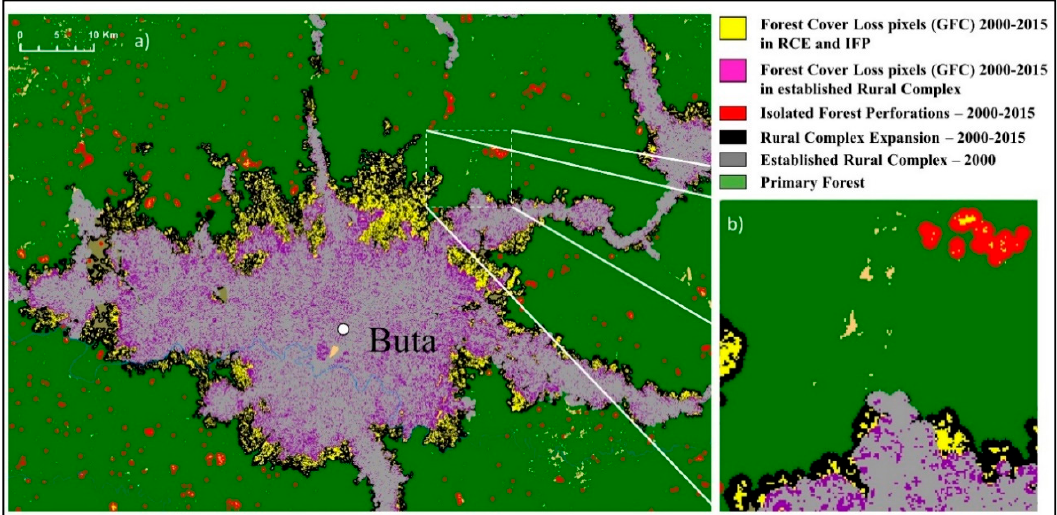
Figure 4. ( a ) The separation of GFC forest cover loss pixels in three areas: (1) in the baseline “established rural complex” for the year 2000 which was established and sampled in [13,14], (2) in the rural complex expansion area (RCE), and (3) in isolated forest perforations (IFP). Buta (2°49 ′ 01.93 ″ N, 24°45 ′ 56.12 ″ E); ( b ) a zoomed in map detail for illustration.